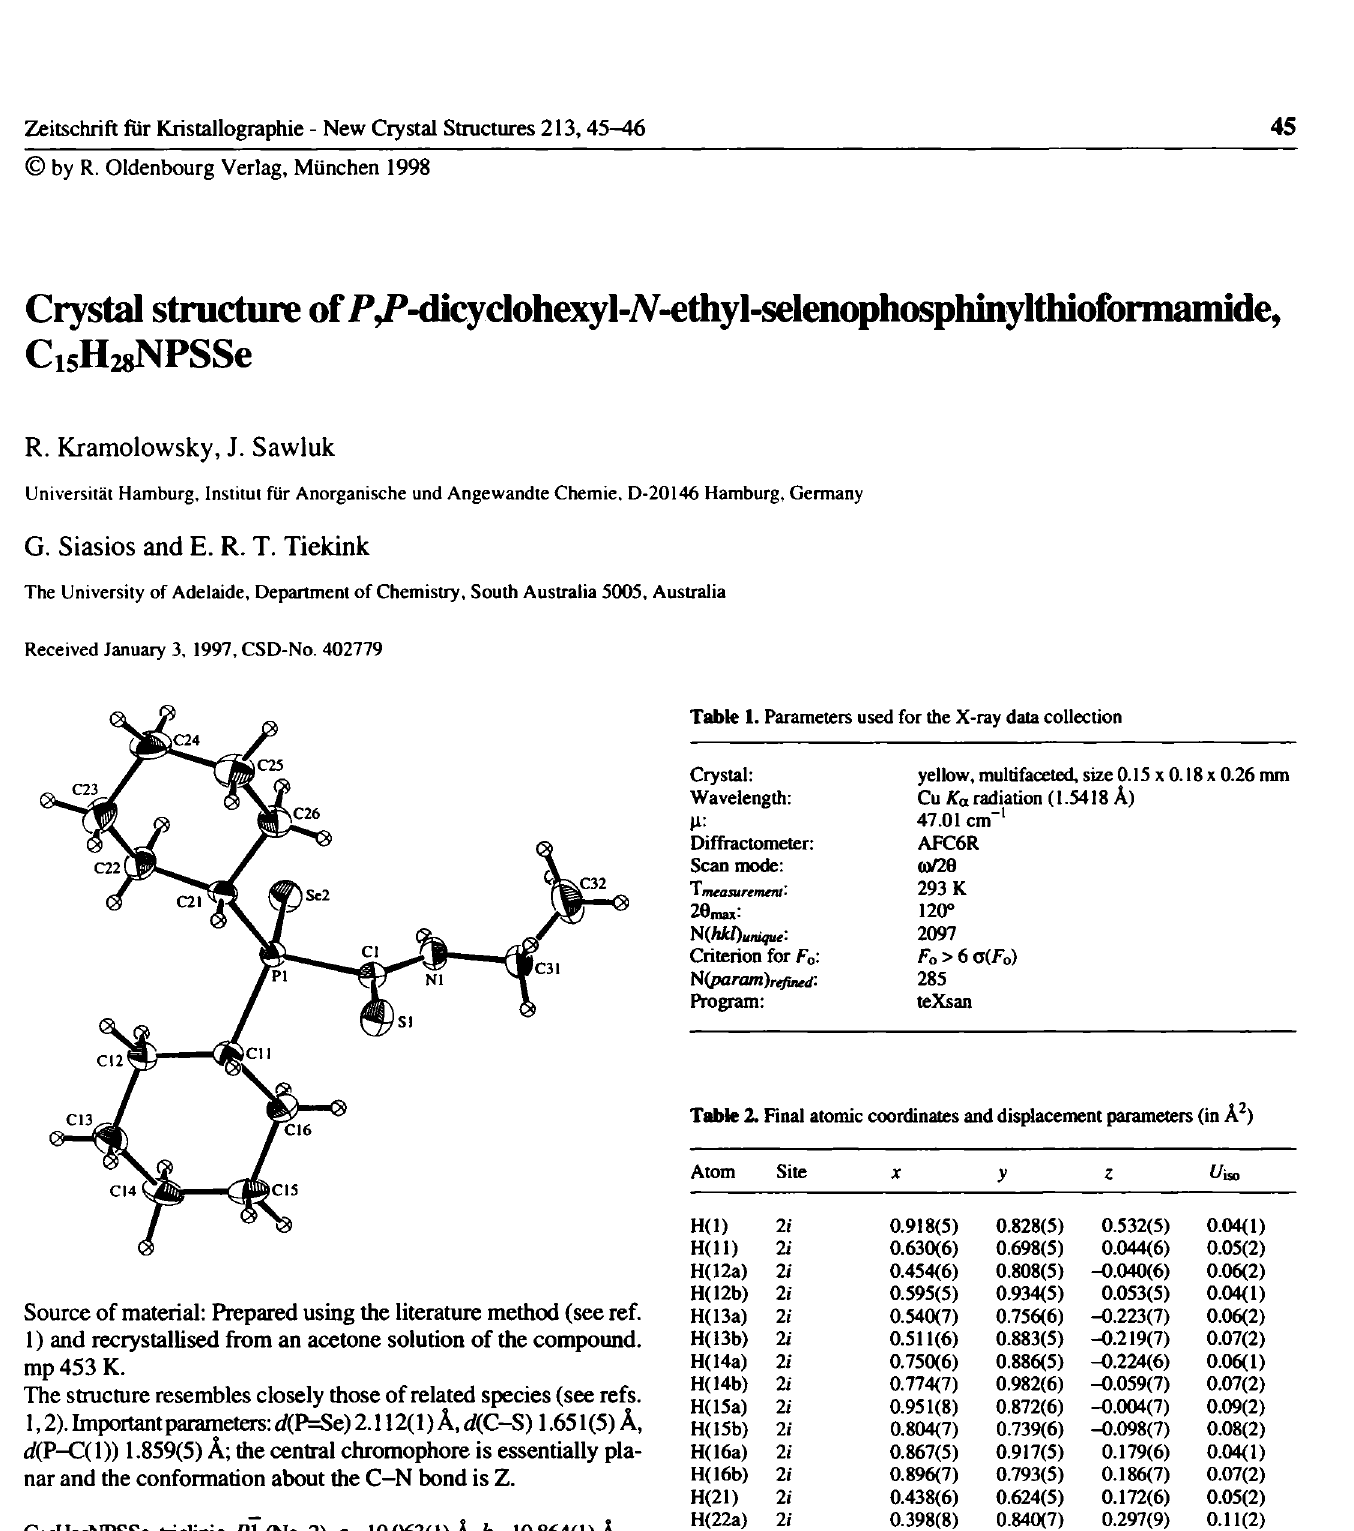
Table 2. Final atomic coordinates and displacement parameters (in